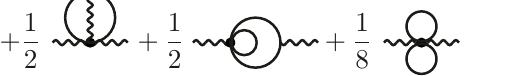
Figure 6 . 2-loop contributions to the 2-point function, originating from 5-point or 6-point Chap- man vertices (the notation is as in figure